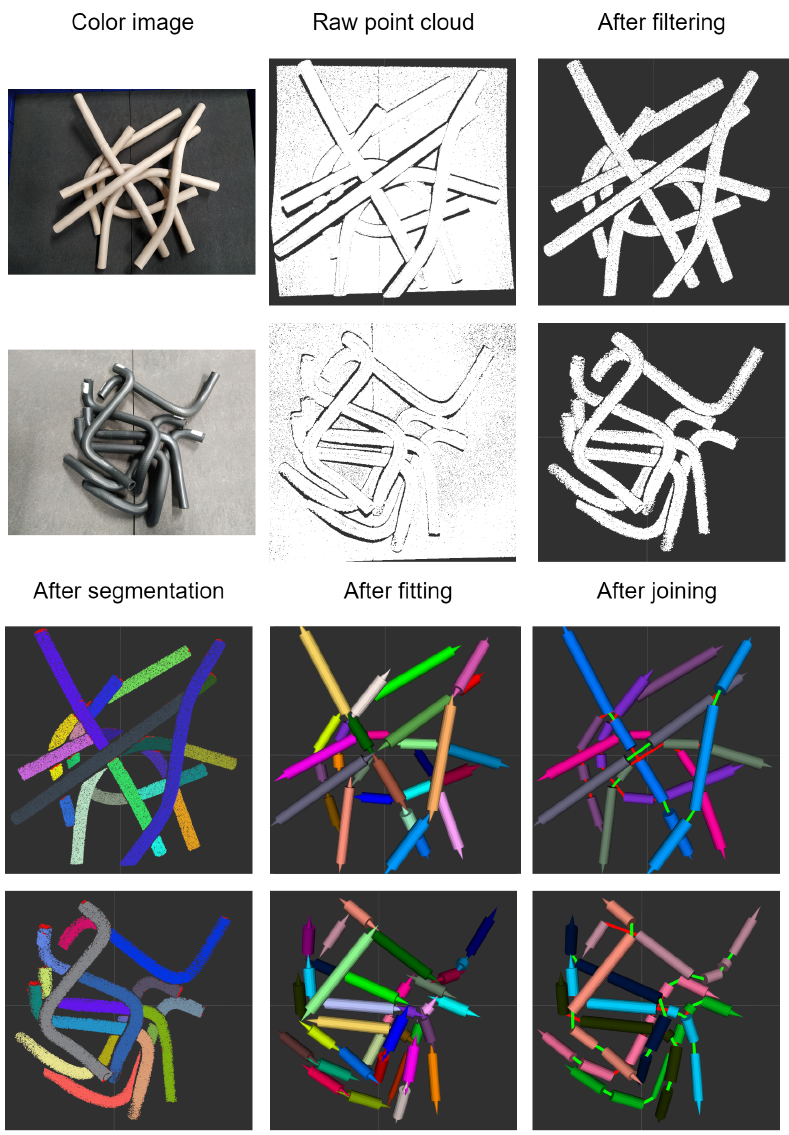
Figure 2. Two examples of each step of the tube modeling